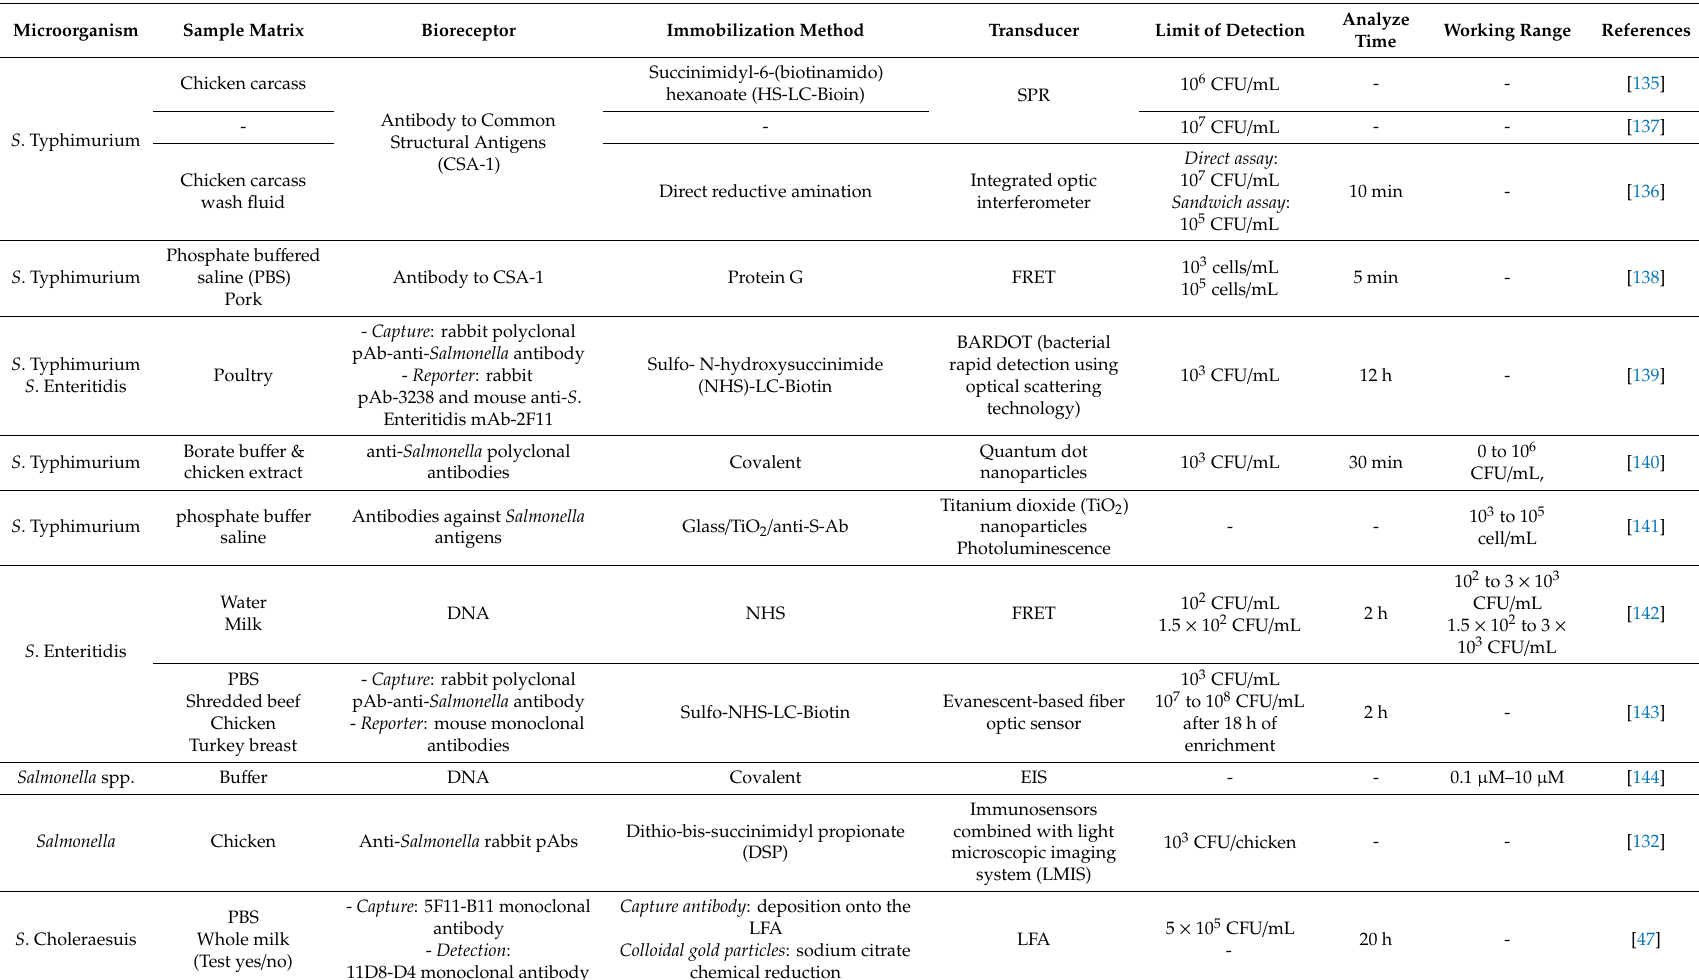
Table 2. Biosensors for Salmonella strains detection in food